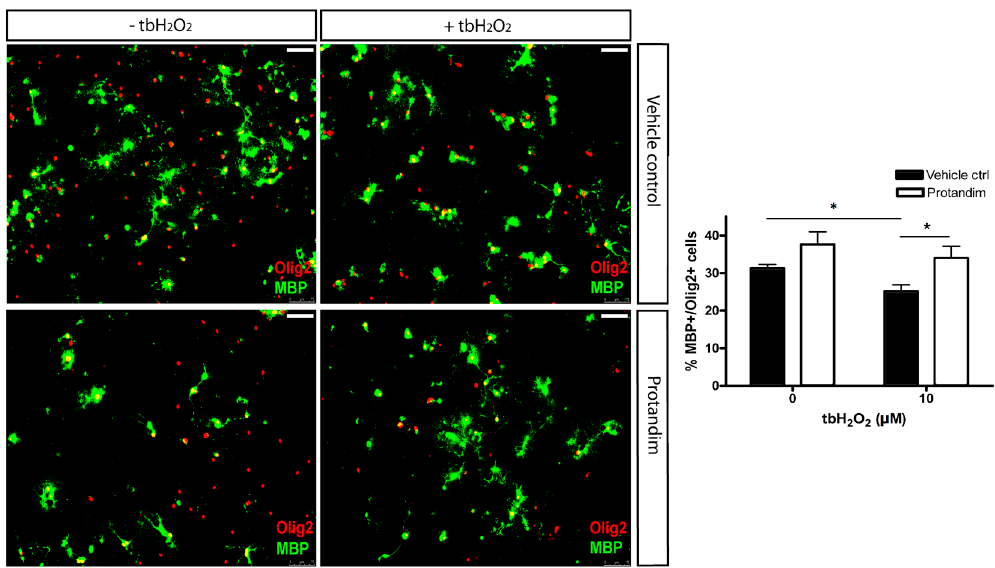
Figure 7. Protandim promotes differentiation of primary rat OPCs under oxidative stress. After 2 day de-differentiation of OLs with growth factors bFGF-2 and PDGF-AA, primary rat OPCs were incubated with 30 μ g/mL Protandim or vehicle control (EtOH) for 24 h. After removal of medium, cells were subsequently exposed to either control medium or medium with 10 μ M tert-butyl hydrogen peroxide (tbH 2 O 2 ) for 5 days. MBP and Olig2 expression were assayed by immunocytochemistry. Data are presented as percentage of control and expressed as the mean ± SEM of 3 independent experiments. Statistics reflect student’s t-test, one-tailed; * p < 0.05.